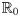

R0 changes with the increase of initial number of mosquitoes per person.
R0 increases when few mosquitoes bite a person, and eventually decreases when there are many more mosquitoes than humans, ρvh > 40. In all cases, R0 for infection transmitted by Wolbachia-free mosquitoes is the largest, followed by R0 for infection transmitted by wAlbB-infected mosquitoes, and R0 for infection transmitted by wMel-infected mosquitoes is the smallest. (a) R0 for DENV transmitted by Ae. aegypti mosquitoes. (b) R0 for DENV transmitted by Ae. albopitus mosquitoes. (c) R0 for CHIKV transmitted by Ae. aegypti mosquitoes. (d) R0 for CHIKV transmitted by Ae. albopictus mosquitoes. (e) R0 for ZIKV transmitted by Ae. aegypti mosquitoes. (f) R0 for ZIKV transmitted by Ae. albopictus mosquitoes.